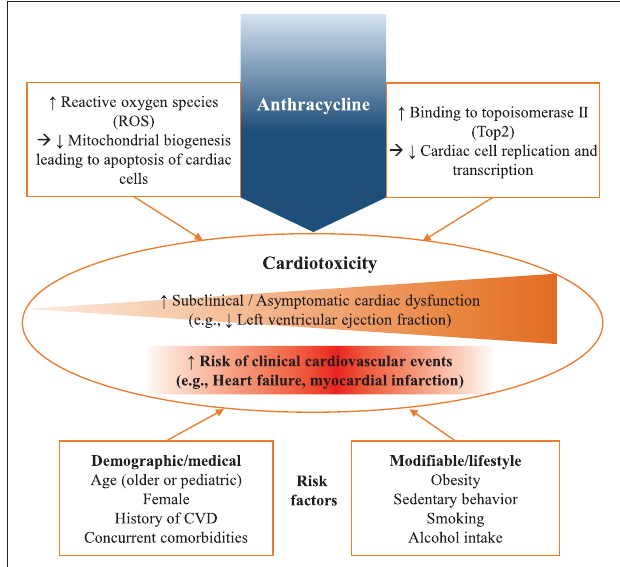
FIGURE 1 | Mechanisms of anthracycline-induced